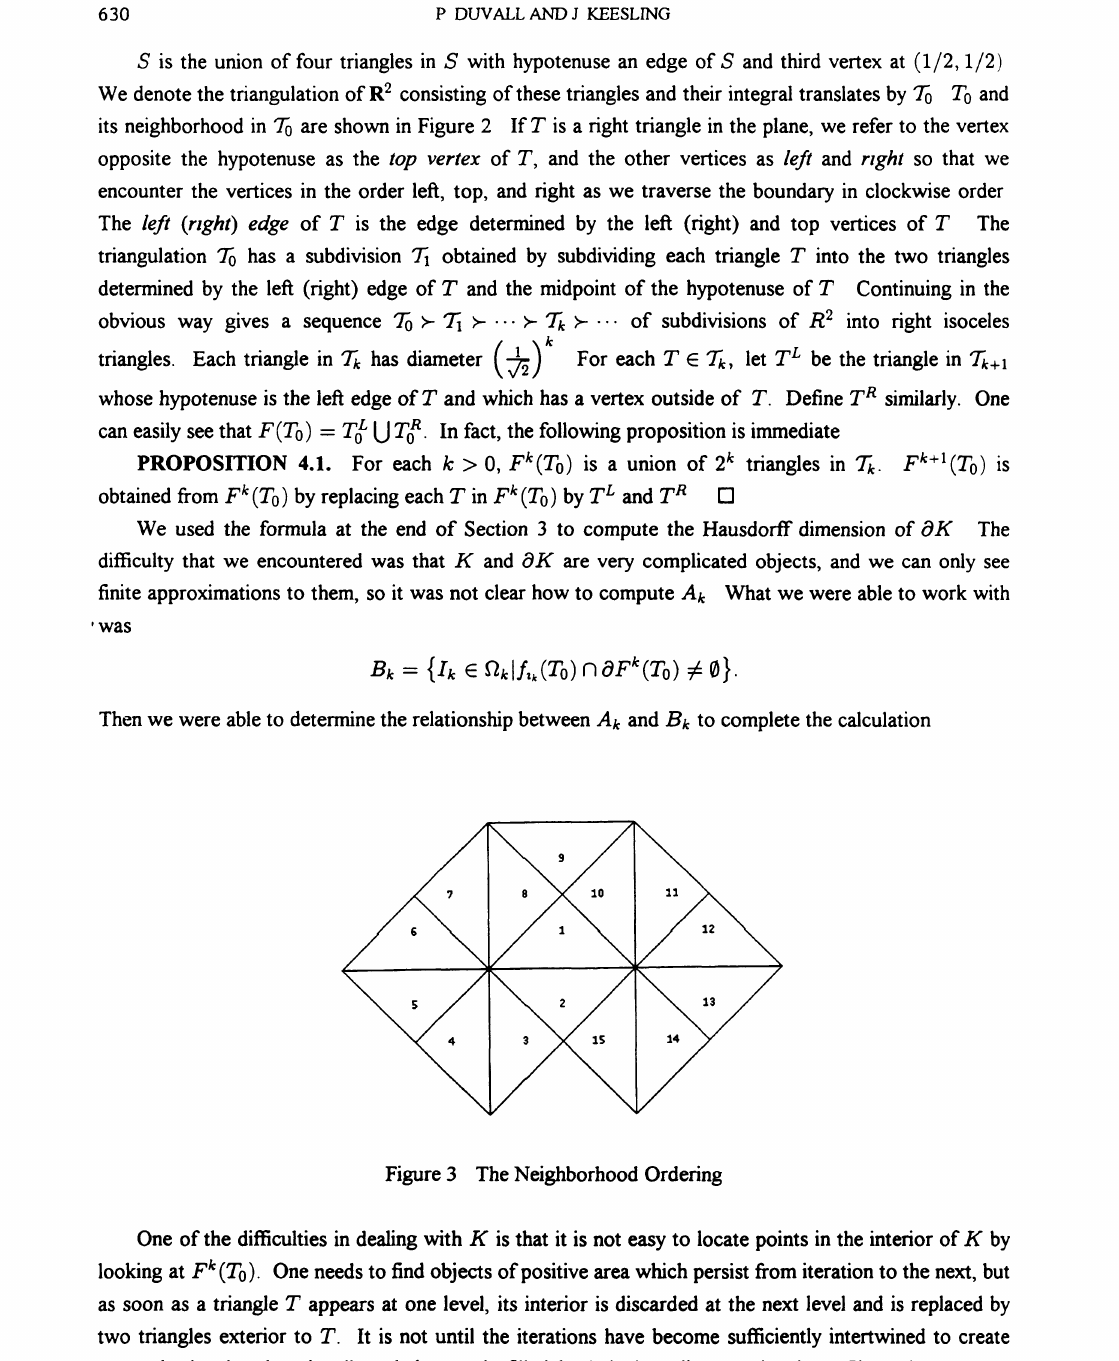
Figure 3 The Ndghborhood